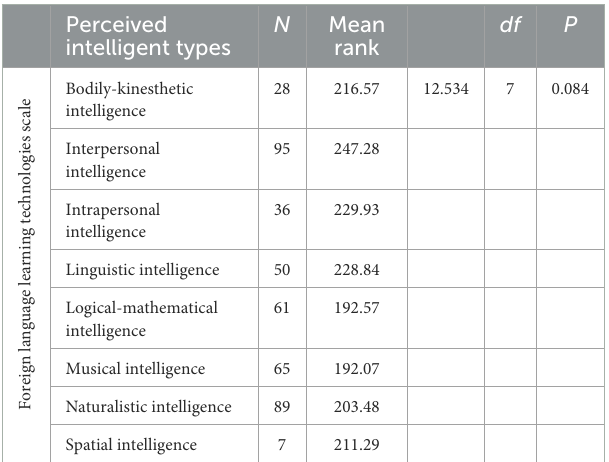
TABLE 4 Kruskal Wallis H -test analysis of the scores university students obtained from the foreign language learning technology scale scores by the self perceived intelligence